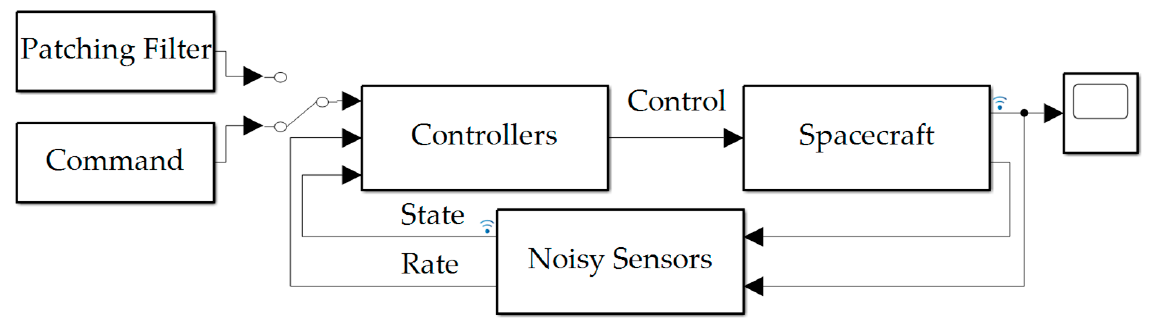
Figure A1. Patching fi lter simulation topology.